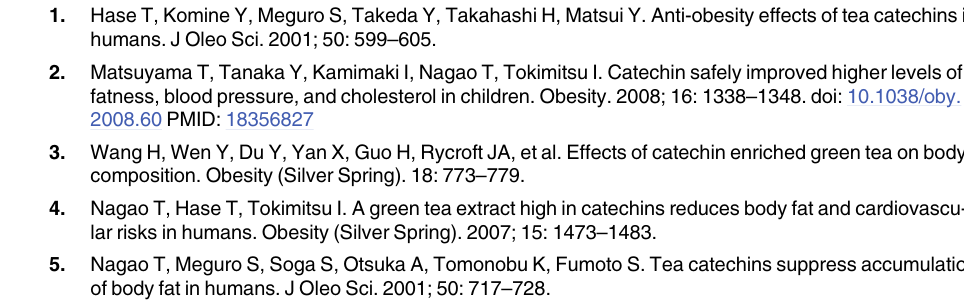
S1 Table. Mean reported energy and macronutrient intake per day in the green tea and pla- cebo